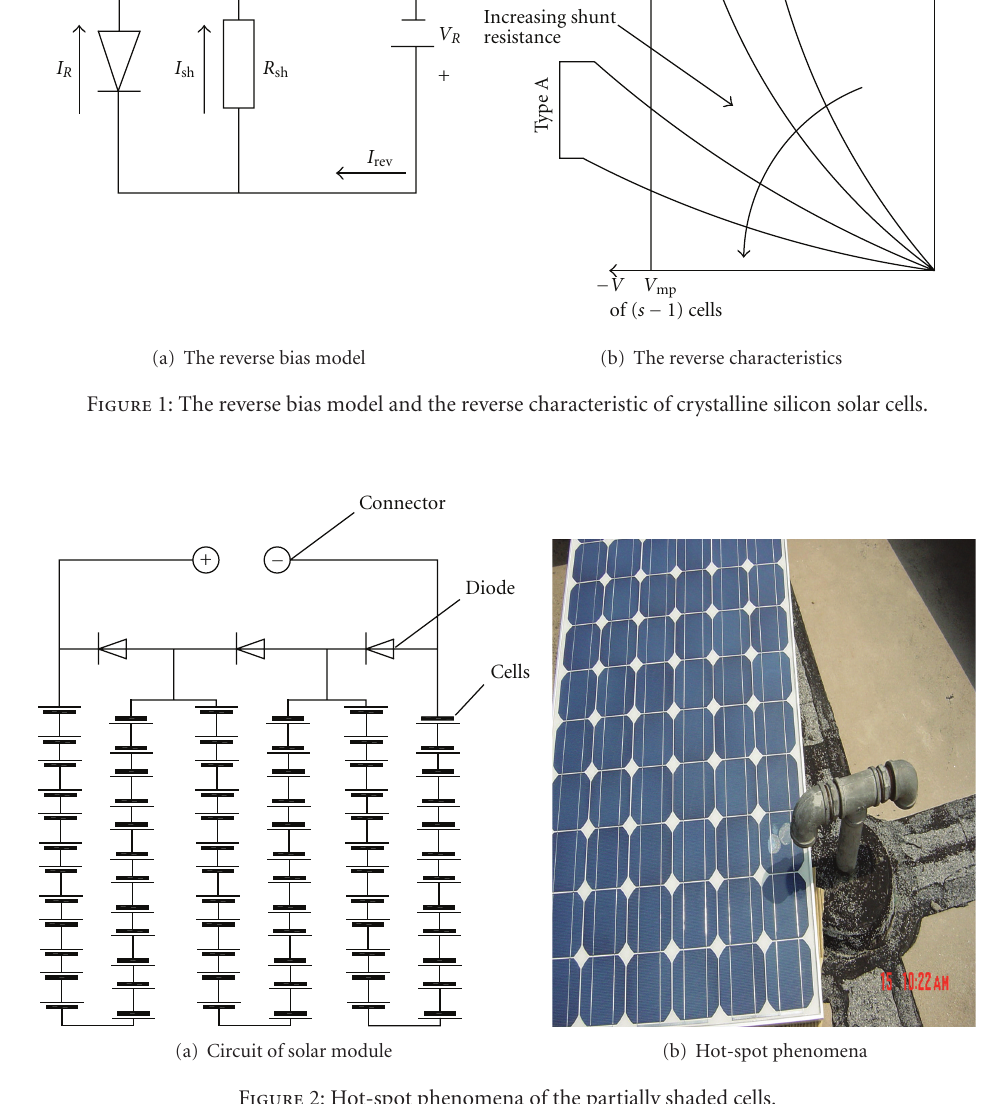
Figure 2: Hot-spot phenomena of the partially shaded